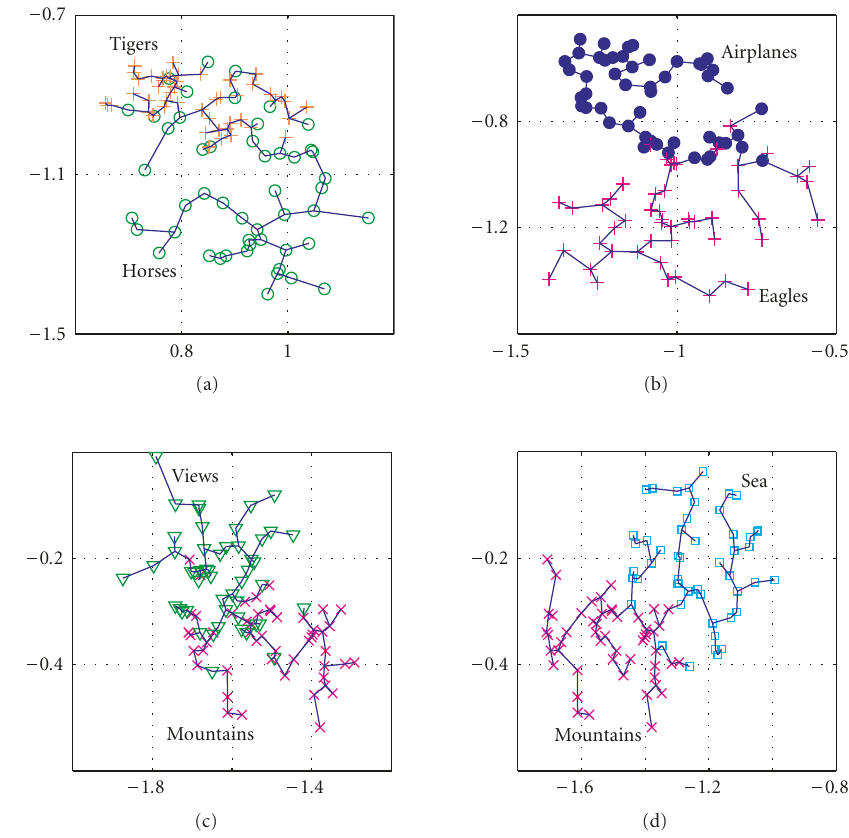
Figure 7: WW -test related measurement of class separability characterizing the cognitive biplot of Figure 6. (a) Tigers versus Horses: W = − 5 . 8431, (b) Airplanes versus Eagles: W = − 7 . 4541, (c) Mountains versus Views: W = − 4 . 8351, and (d) Mountains versus Sea: W = − 8 .